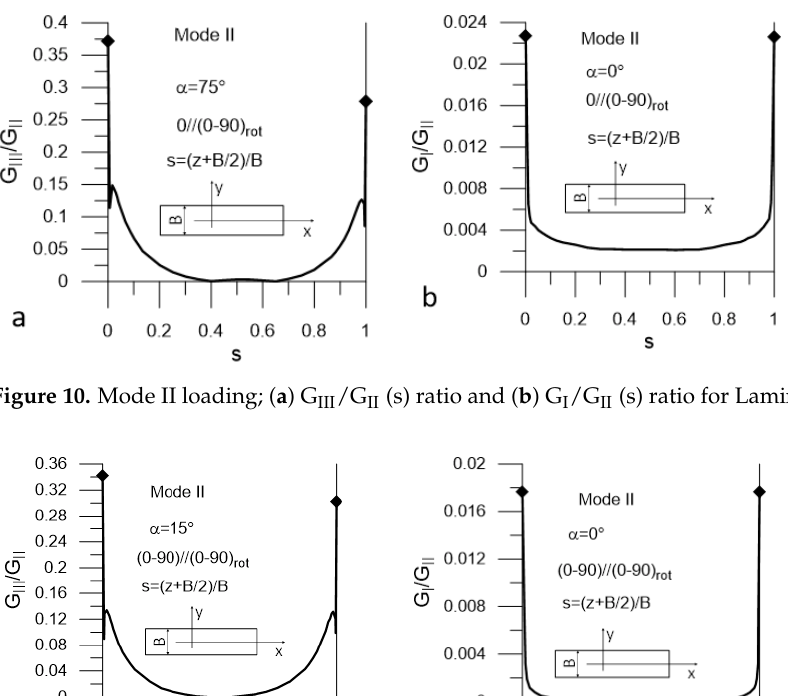
Figure 9. Mode I loading; ( a ) G II /G I (s) ratio and ( b ) G III /G I (s) ratio for Laminate B.